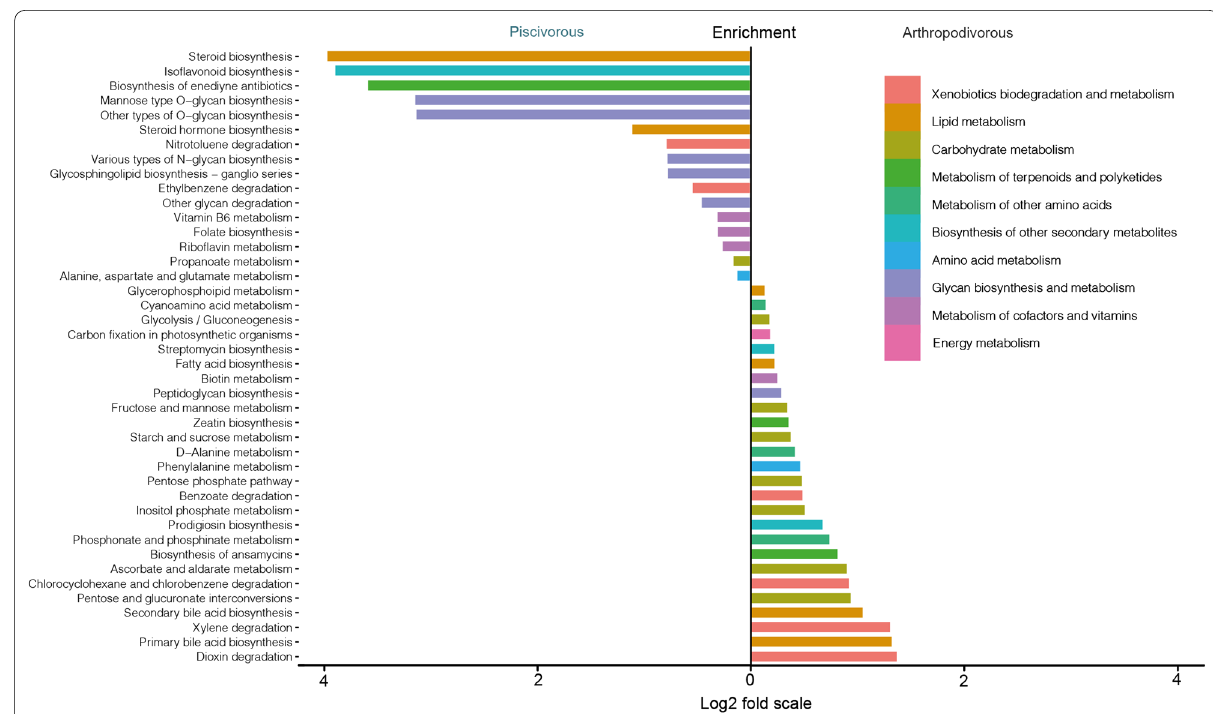
Fig. 6 Differential abundance analysis of Piphillin predicted KEGG pathways of piscivory‑associated microbial communities (left) and arthropodophagous‑associated microbial communities (right) at the significance level of p <